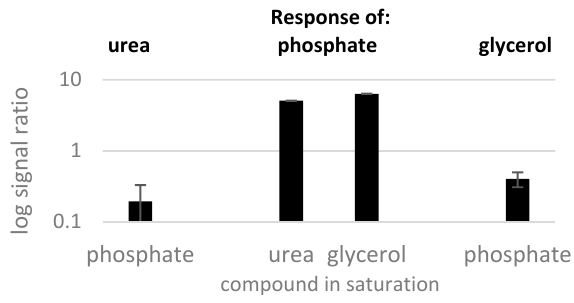
Figure 9. Response of 500 µM of urea, 100 µM phosphate, and 200 µM glycerol as indicated above the bars in presence of 5 mM of the saturated compound indicated on the x -axis, analyzed on an Agilent GC 6890.